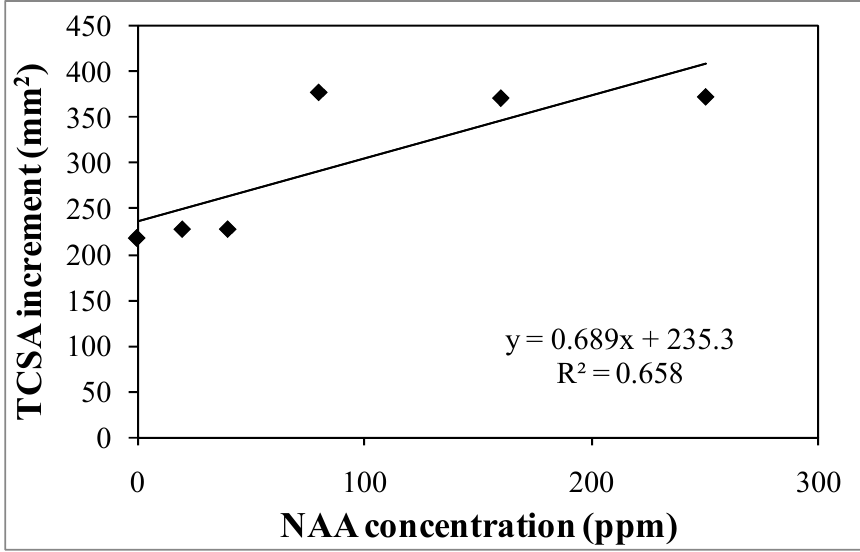
Figure 6. Relationship between NAA concentrations and increments in trunk cross-sectional area (TCSA) from the time of application of the NAA treatments (June) to the end of the season (Decem- ber) in a young intensive olive orchard of the cultivar Moraiolo. Values are means of 4 replicates per treatment.